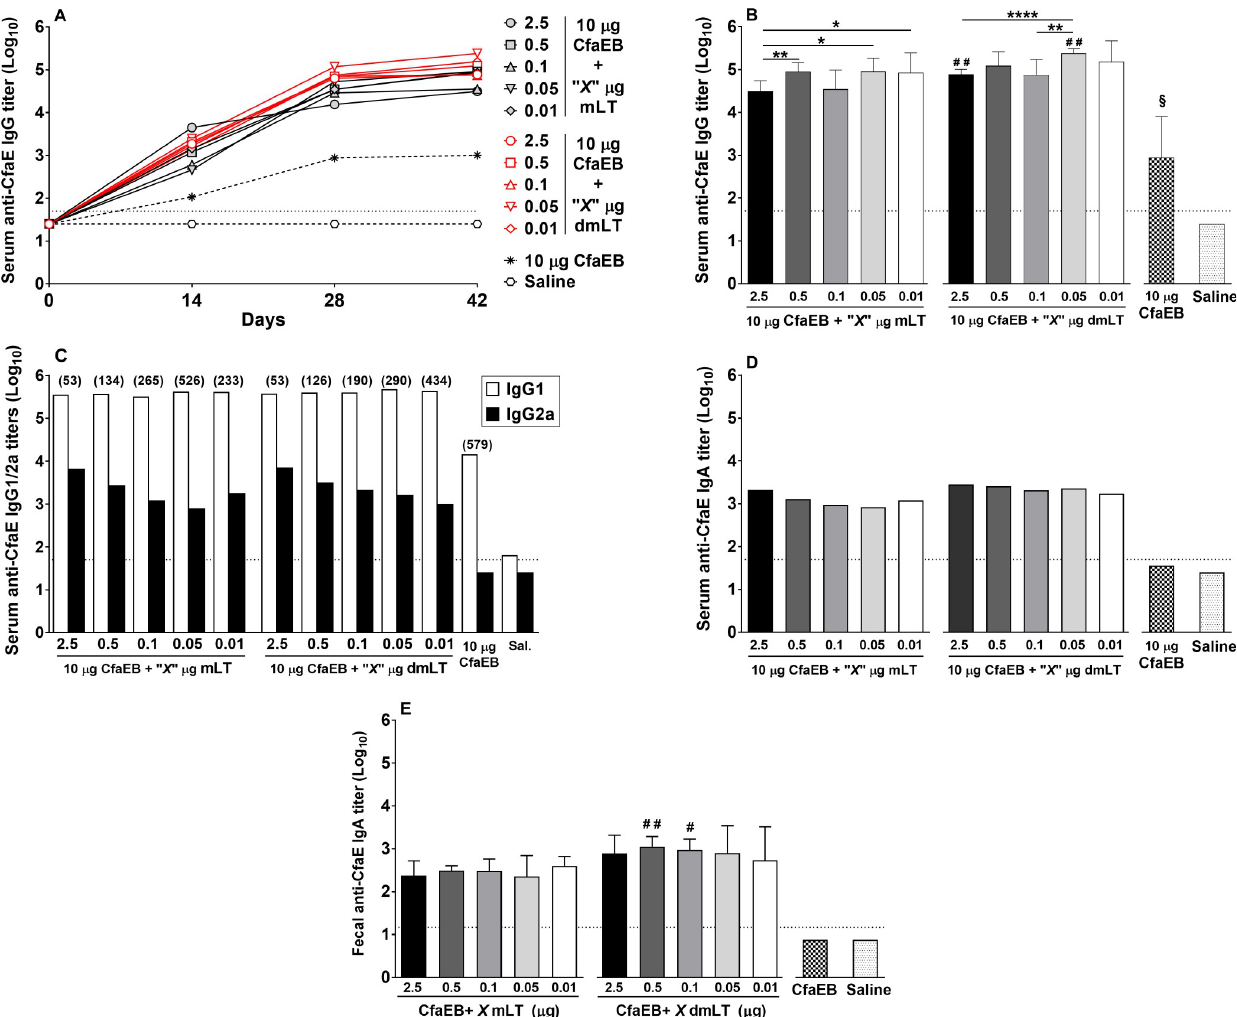
Fig 4. Anti-CfaE antibody response. Mice were immunized by the ID route with varying doses of either mLT or dmLT in the presence of 10 μ g CfaEB (see Materials and methods for details). (A) Kinetics of anti-CfaE IgG Ab titers for all groups on d0 (evaluated with pool of 7 animals/group), d14 (evaluated with pool of 7 animals/group), d28 (evaluated with pool of 5 animals/group), and d42 (evaluated in individual sera, 5 animals/group) (for clarity, only mean is indicated); (B) Geometric mean (+95% confidence interval) titers of log 10 transformed anti-CfaE IgG Ab titers on d42 for all groups; (C) Serum anti-CfaE IgG1 and IgG2a Ab titers on d42 performed with pooled sera (bars represent the mean of duplicate assays); IgG1/IgG2a ratios are shown in parentheses; (D) Serum anti-CfaE Ab IgA antibody titers on d42 performed with pooled sera (bars represent the mean of duplicate assays); (E) Fecal IgA anti-CfaE Ab titers on d35. Dotted horizontal line represents the limit of detection for the assays. � P < 0.05, �� P < 0.01, and ��� P < 0.001 indicated for statistical comparisons performed within mLT or dmLT groups; # P < 0.05, # # P < 0.01, and # # # P < 0.001 indicated for statistical comparisons performed between the same dose of mLT and